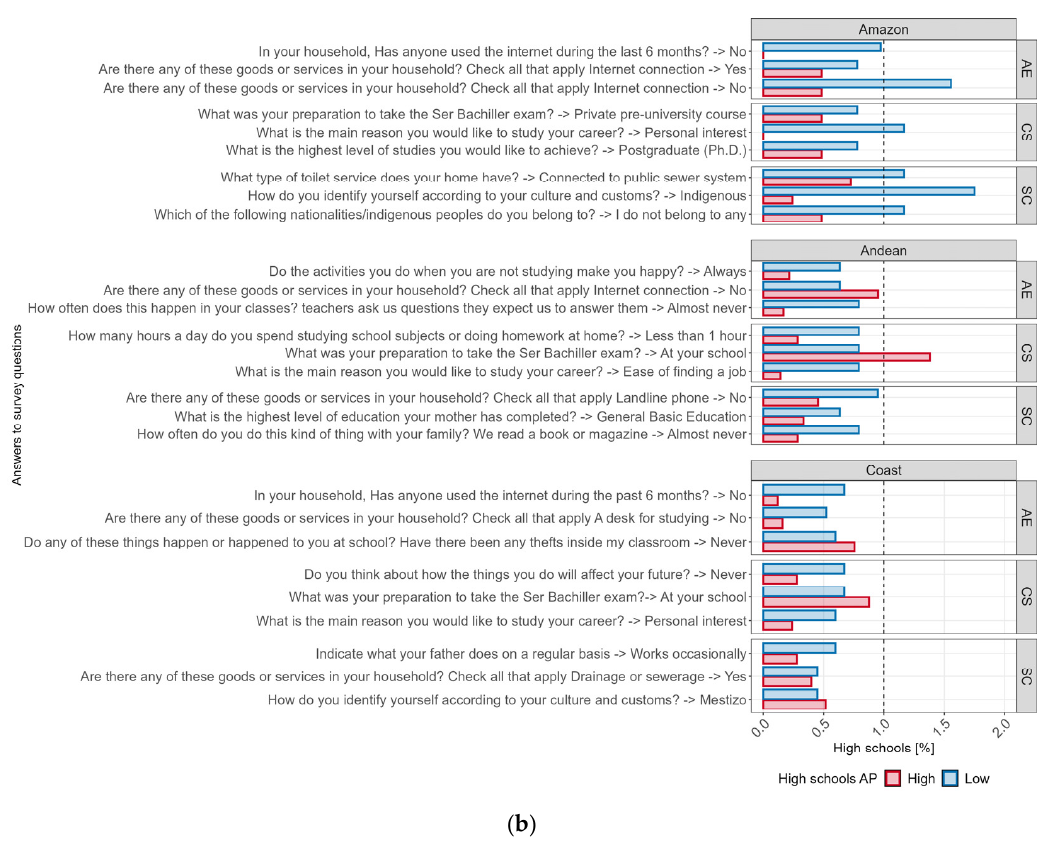
Figure 7. Frequent answers to survey questions derived from feature selection with the Boruta algorithm for ( a ) high and ( b ) low academic performance (AP) classifications. Answers are organized according to region and theme group.